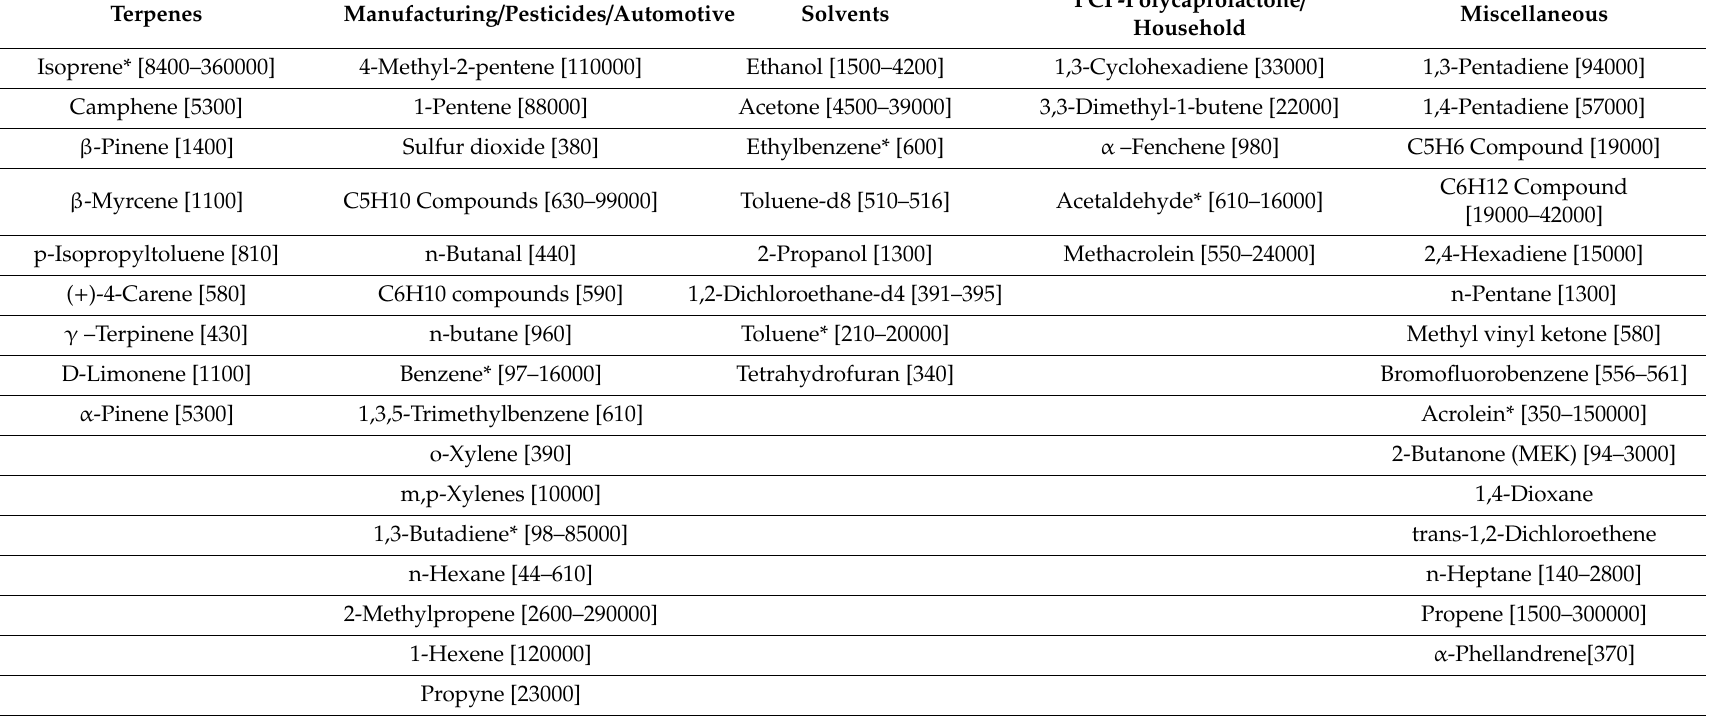
Table 2. Vapor phase constituents in counterfeit